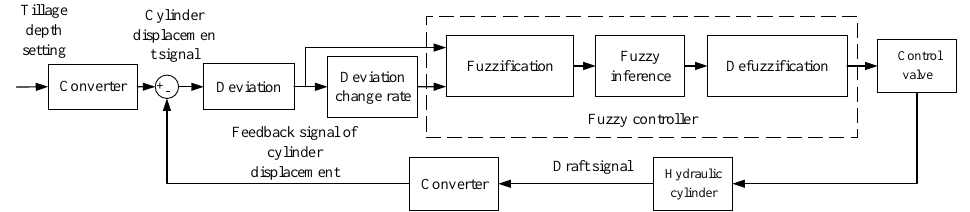
Figure 6. Principle diagram of fuzzy control algorithm.